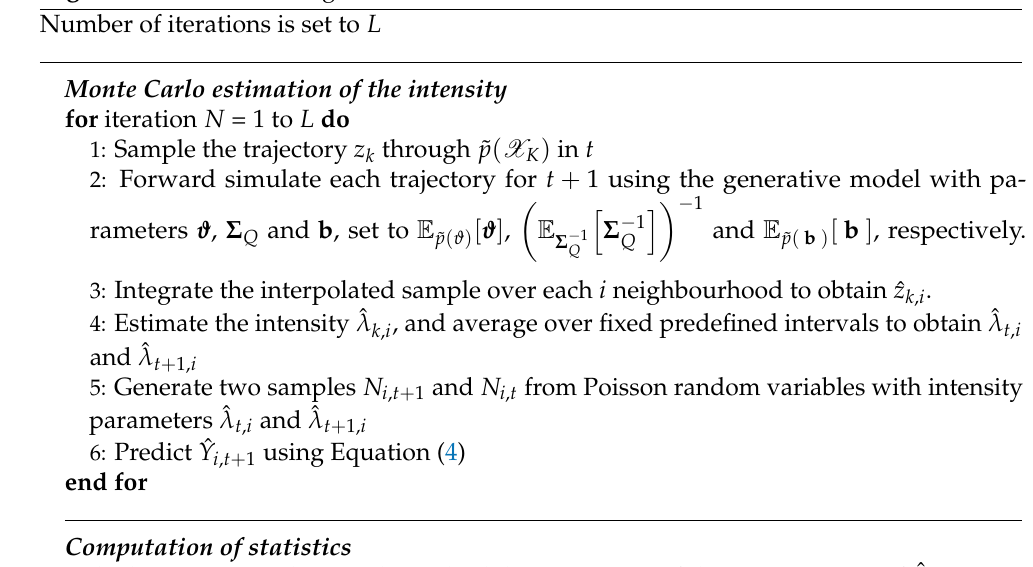
Algorithm 1 Prediction algorithm for time t +